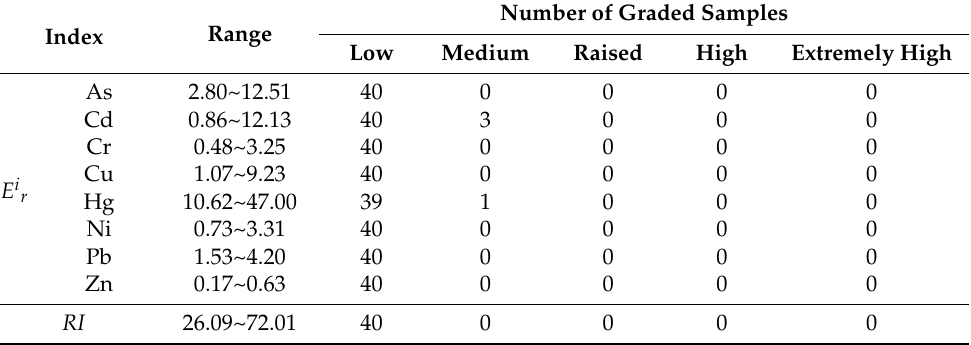
Table 8. Classification statistics of potential ecological risk index of heavy metals in the soil of the non-karst